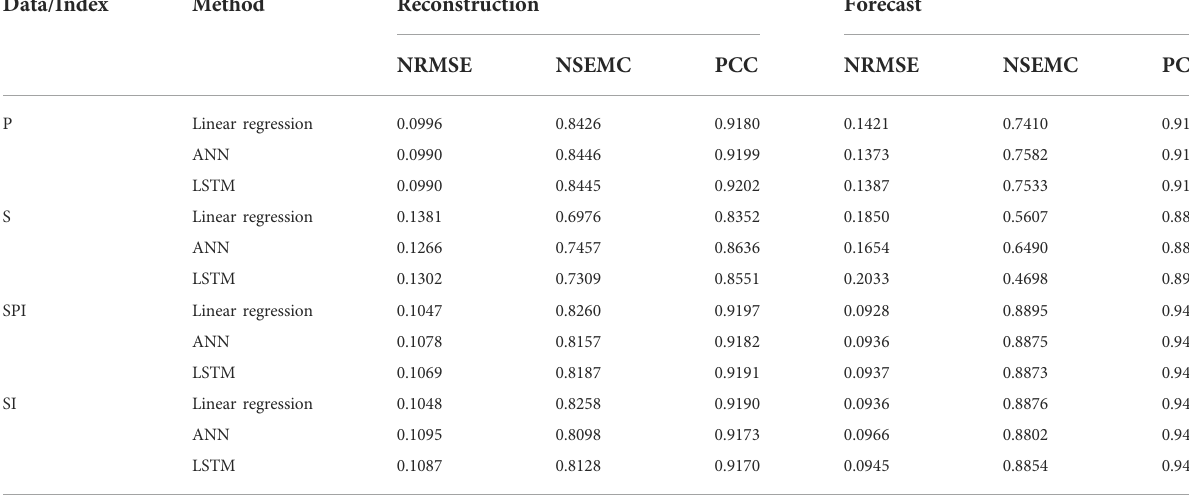
TABLE 1 Evaluation of runoff reconstruction and forecast at the TC-CD stations.